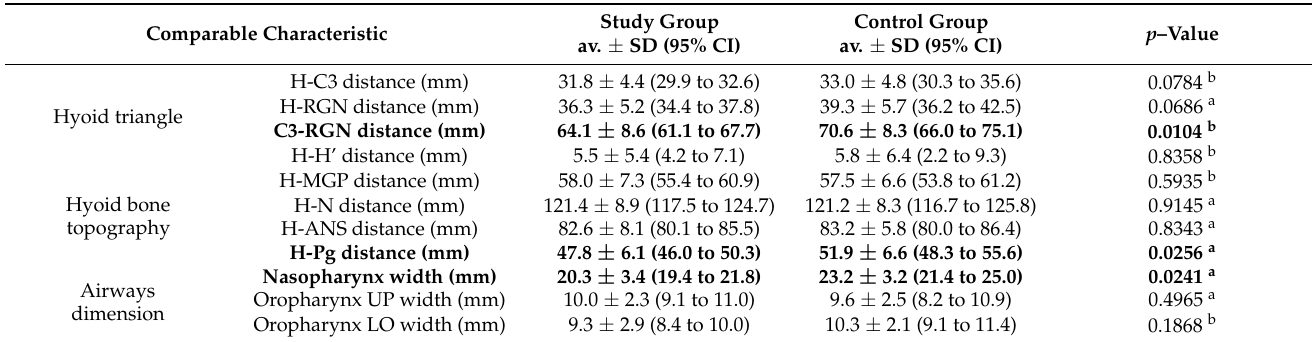
Table 2. The comparison of the examined parameters regarding the hyoid bone position and the width of nasopharynx and oropharynx during the initial examination between study group and control group.